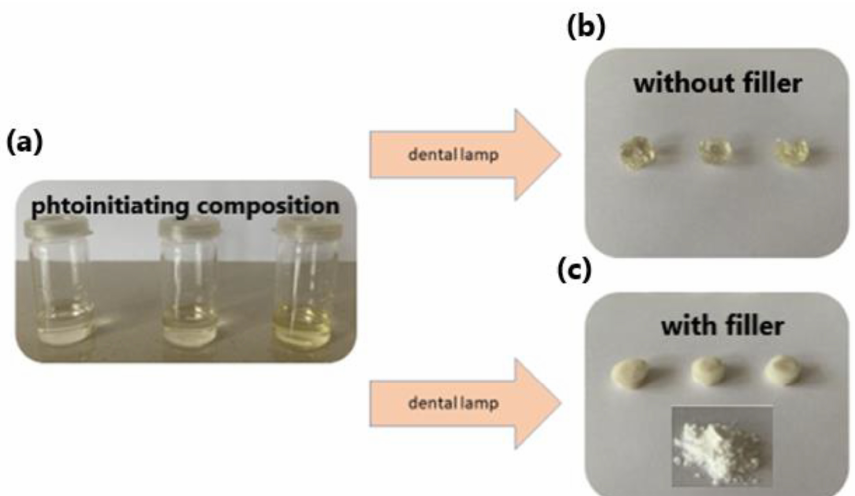
Figure 41. ( a ) Resins polymerized with AN2 (left), AN3 (center) and AN8 (right) in combination with diMPhTAA. ( b ) without fillers. ( c ) with fillers. Reprinted from Ref. [223] Copyright 2021, MDPI